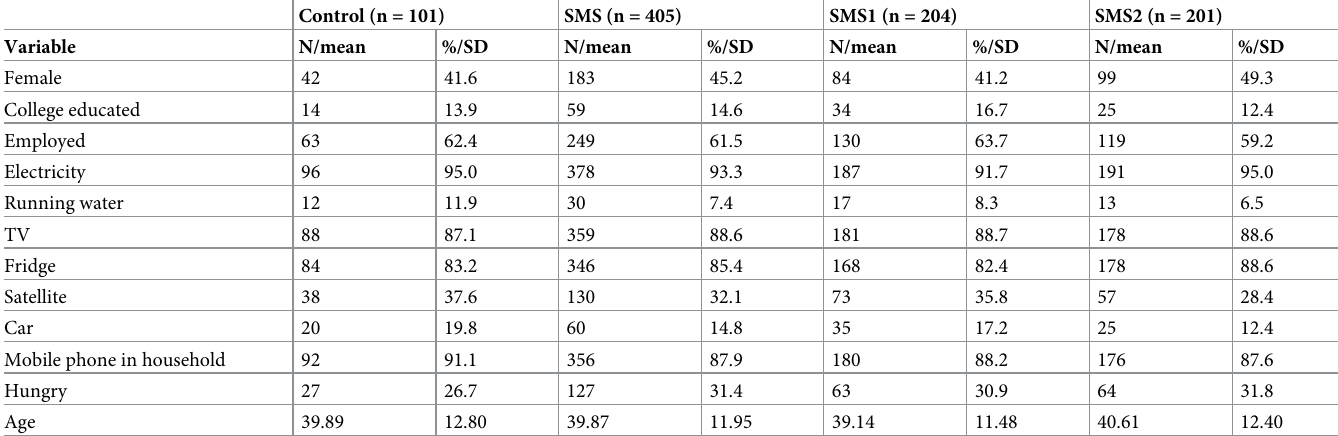
Table 1. Baseline characteristics (full